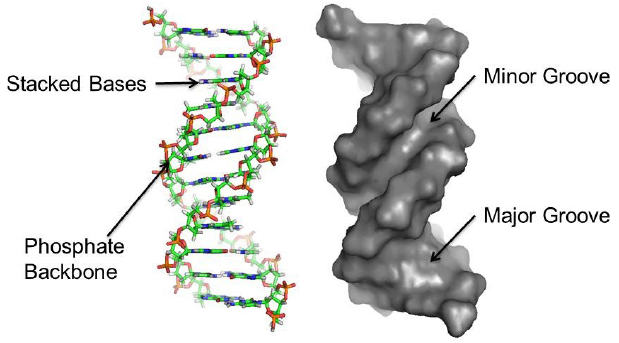
Figure 4. Handout example. Handouts were designed that allowed the students to identify key features of the molecule